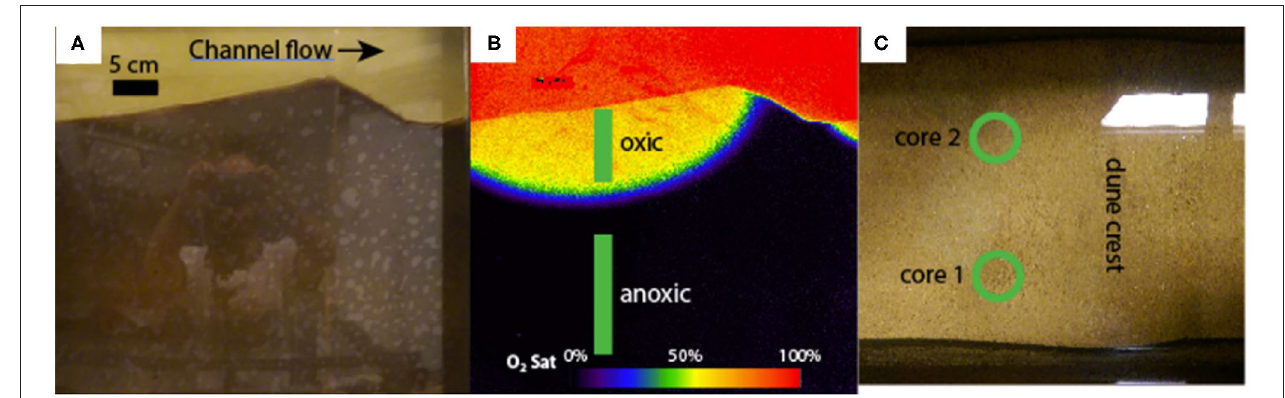
FIGURE 2 | (A) is a true-color image of the fifth bedform from the left of the flume. (B) is a planar optode image of the same bedform, false-colored to show the dissolved oxygen saturation. The oxic and anoxic sampling zones are also shown in (B) . (C) is a top-down view of the same bedform, with the two core locations indicated with green